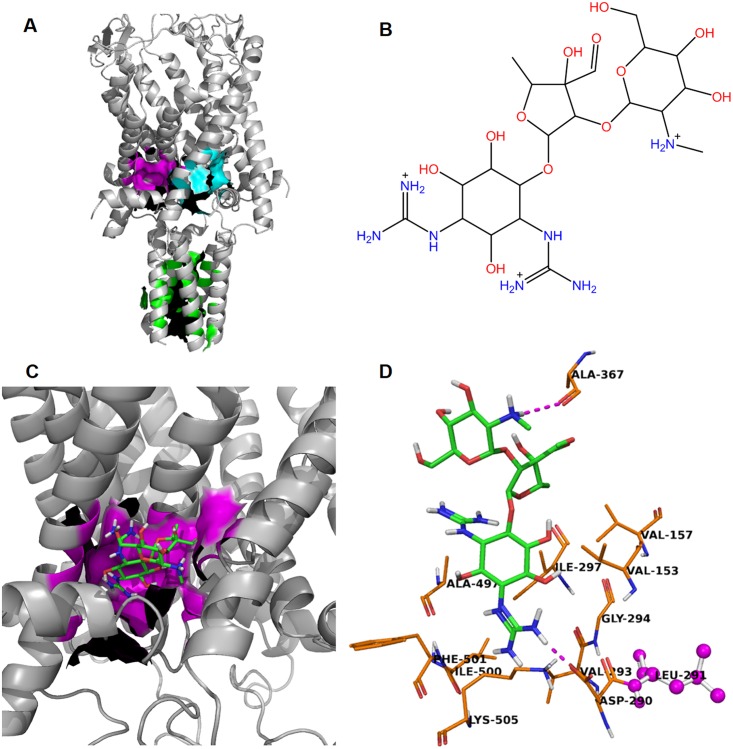
Docking studies representing how DHS binds to the closed conformation of Ec-MscL.(A) Three binding sites identified by SiteID using the last snapshot of the ligand-free MD simulation. The green binding site is located inside of the channel formed by 19 C-terminal helical residues from monomer 1: L122, I125, L129, Q132, N133; monomer 2: L258 (L122), L265 (L129); monomer 3: L401 (L129), Q404 (Q132), N405 (N133); monomer 4: L530 (L122), I533 (I125), L536 (L128), Q540 (Q132); monomer 5: L666 (L122), I669 (I125), L672 (L128), L673 (L129), Q676(Q132)). If a binding site residue does not belong to the first monomer, then the corresponding residue ID of the first monomer is provided in the followed parenthesis. The magenta binding site has a smooth deep pocket formed by residues from monomer 2: V153 (V17), V157 (V21); monomer 3: D290 (D18), V293 (V21), G294 (G22), I297 (I25); monomer 4: A497 (A89), I500 (I92), F501 (F93), and K505 (K97). The cyan binding pocket is the smallest in term of volume of the cavity and formed by Residues from monomer 1: F10; monomer 2: D154 (D18), G158 (G22), I161 (I25); monomer 3: A361 (A89), I364 (I92), F365 (F93), I368 (I96), and K369 (K97). (B) Molecular structure of DHS. (C) The best docking pose of DHS bound to the magenta binding site. (D) A focused look at DHS and its surrounding residues at the magenta binding site. Two hydrogen bonds (magenta dashed-line) are formed between the ammonium functional group of DHS and A367 (A95) and one guanidinium functional group of DHS with monomer 3: D290 (D18). L291 (L19), shown in magenta ball and stick representation, is known as a “hot spot” in the MTSPEG5000 competition assay.